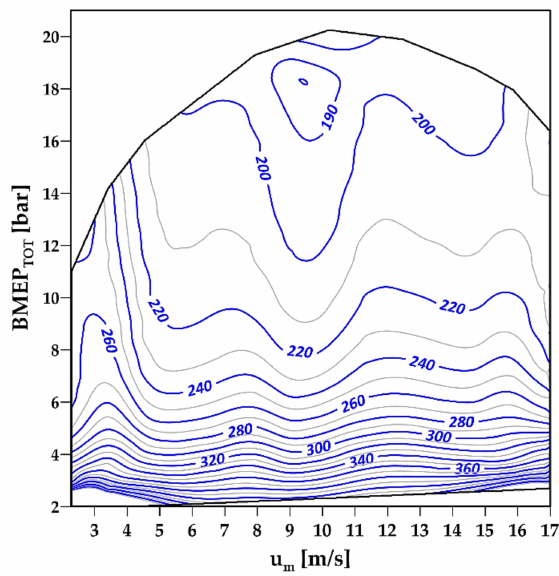
Figure 15. Brake specific fuel consumption (g/kWh) of the compound engine, as a function of the overall load and mean piston speed ( T 4 /T 1 = 4.0, η T = 0.70).